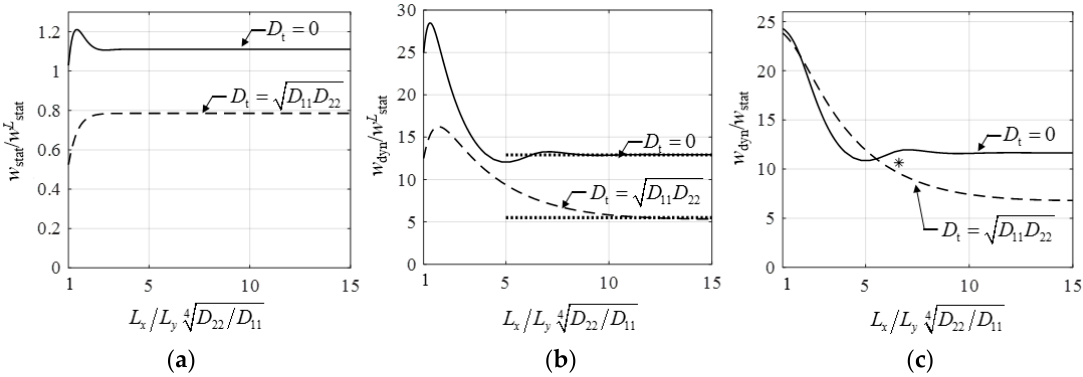
Figure 8. ( a ) Static displacement, ( b ) dynamic displacement of the steady-state solution of a plate excited by sin ( ω c t ) , and ( c ) dynamic amplification factor as a function of the plate aspect ratio (the displacements are normalized by the static displacement of an L y wide plate strip: w L 3 4 w p L D π= ). Equation (28) is given in ( b ) by dotted lines. The result of the numerical example is shown by an asterisk in ( c ).